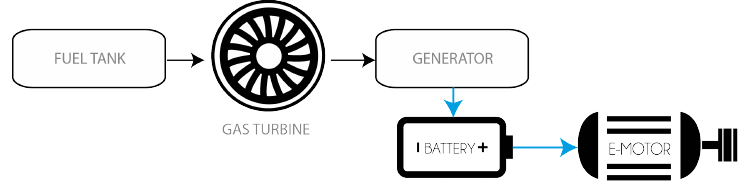
Figure 6. A diagram of the configuration of MGT-ER.